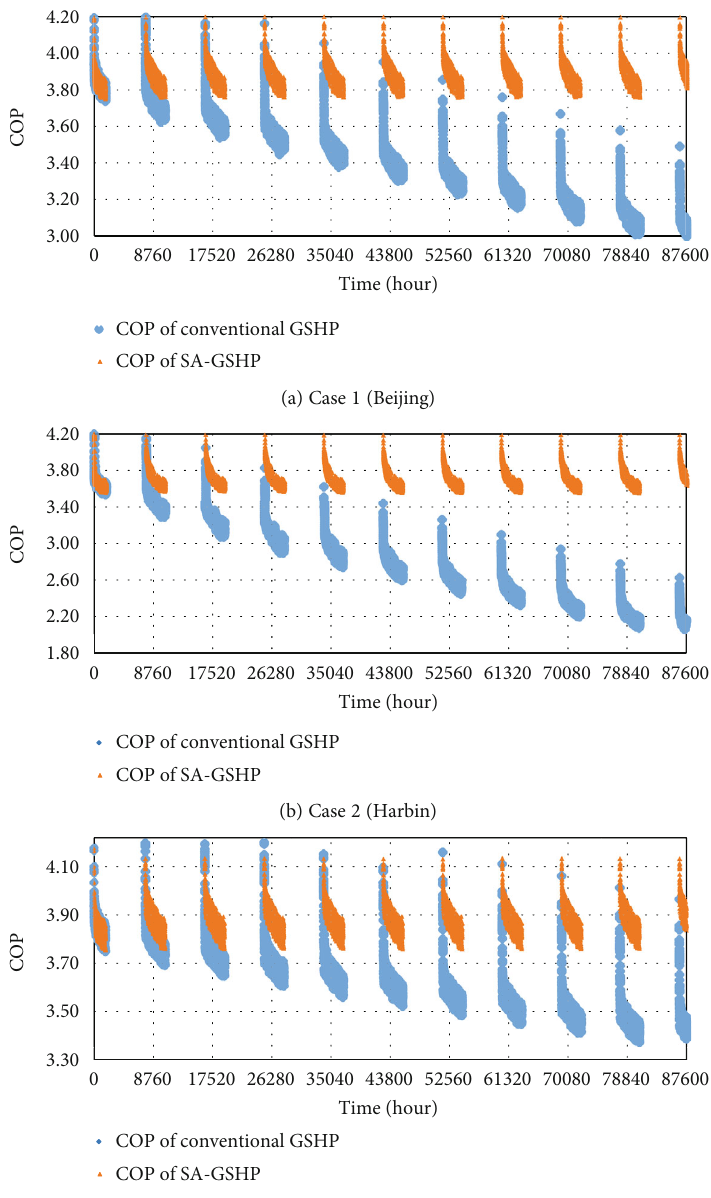
Figure 12: Ten-year trend in dynamic quality during heating for the GSHP and SA-GSHP